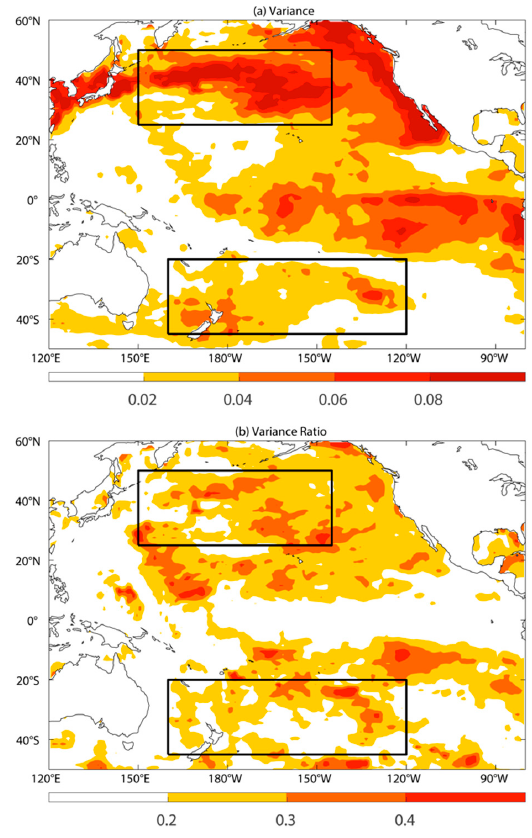
Figure 1. ( a ) The internal multidecadal variance of sea surface temperature (SST) anomalies in the Pacific. Unit: ( ◦ C) 2 . ( b ) The ratio between the internal multidecadal variance and total variance of SST. The rectangular boxes in the mid-latitude North and South Pacific are regions in which the indices of the internal multidecadal variability in the North and South Pacific (NPIMV and SPIMV) are defined.